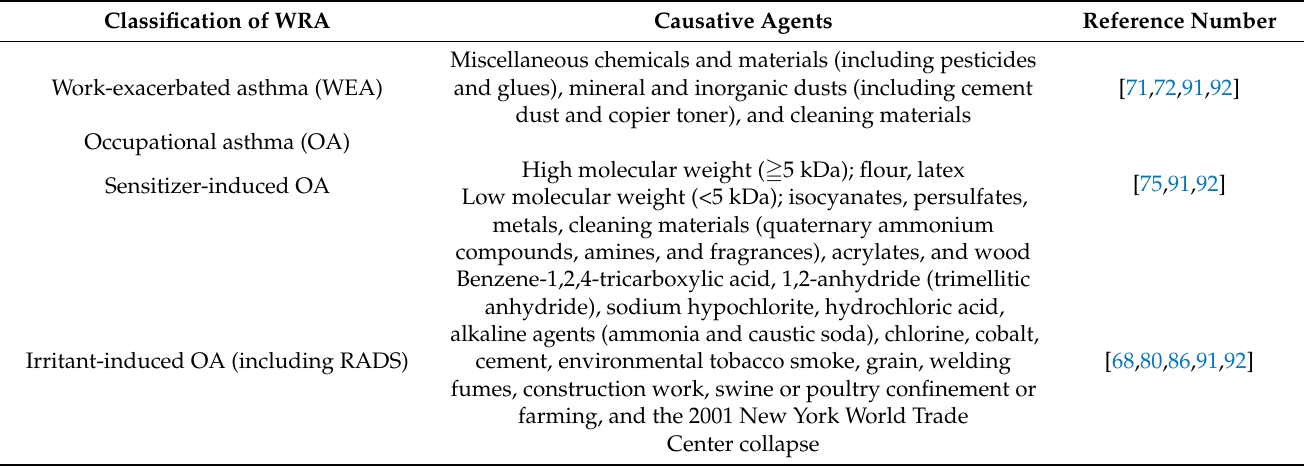
Table 3. Work-related asthma (WRA) and causative